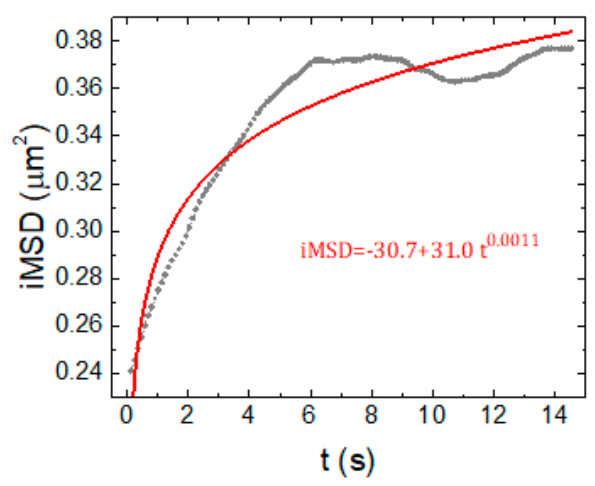
Figure 4. Representative i MSD plot of a neuronal projection at DIV12 (grey trace). Red trace: shifted-power fit with R 2 = 0.91 and equation shown in red.